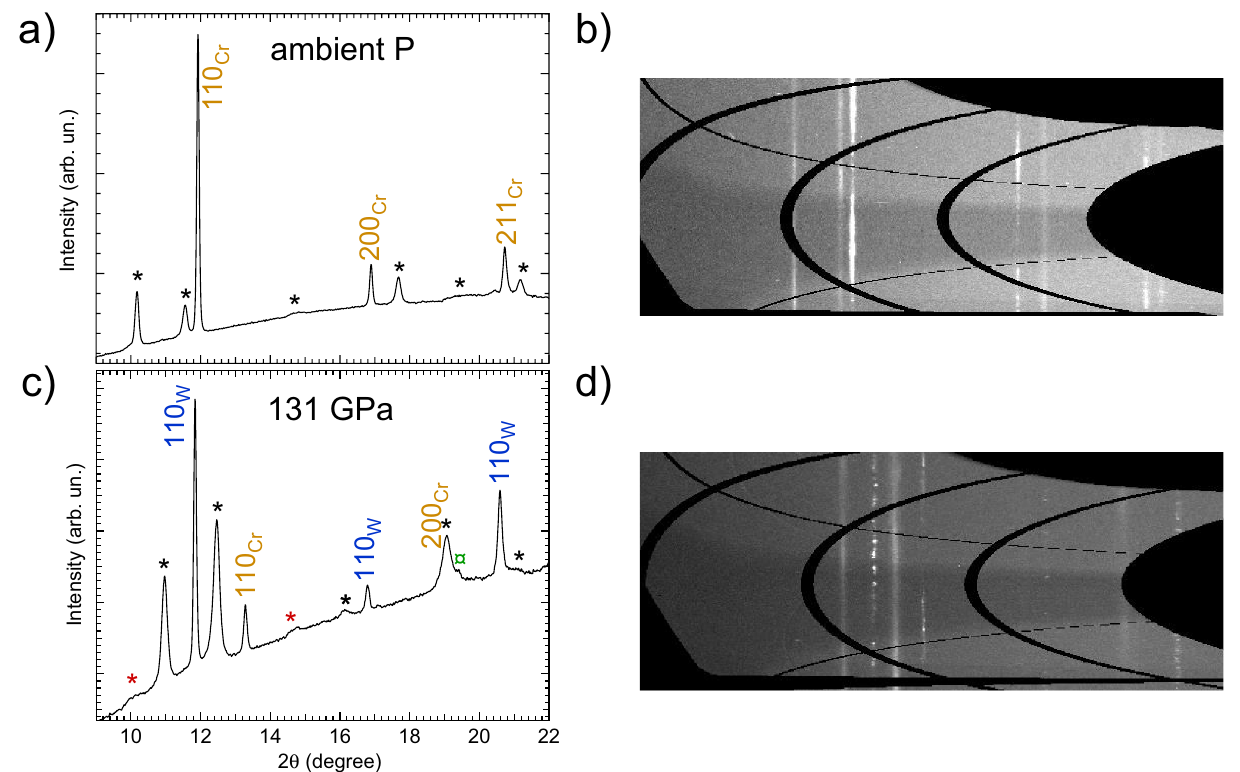
Figure 6. Integrated powder XRD patterns of Cr at the lowest ( a ) and the highest ( b ) P reached in the present experiment and their corresponding image plates ( c , d ), respectively.The different coloured asterisks are indicating the peaks from the Re gasket. The empty green symbol labels the peak obtained from solid He. The pattern in ( a ) was collected before the He loading and the DAC was positioned to obtain only the signal from Cr. In ( c ), the DAC was positioned to obtain signal from both Cr and W (the pressure standard)